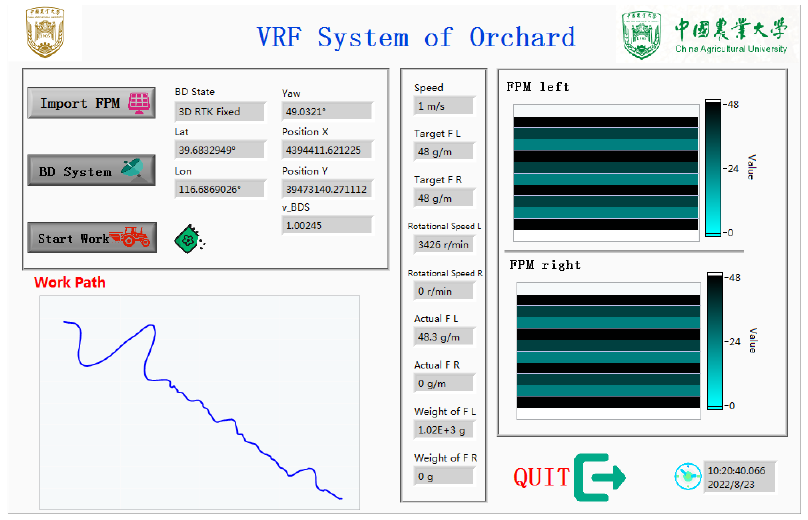
Figure 4. Man-machine Interface.